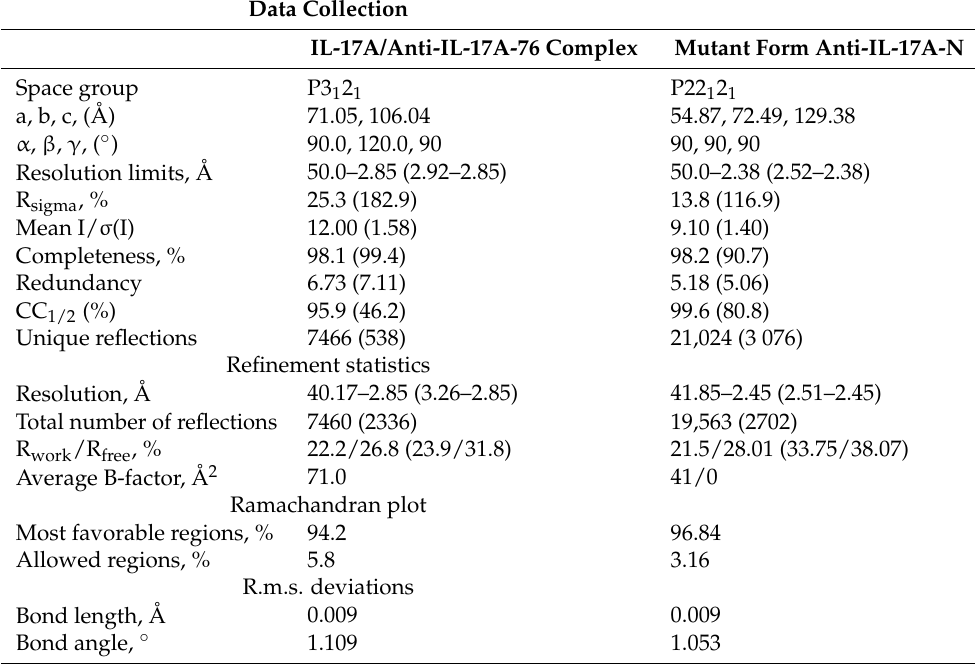
Table 6. Data collection and refinement